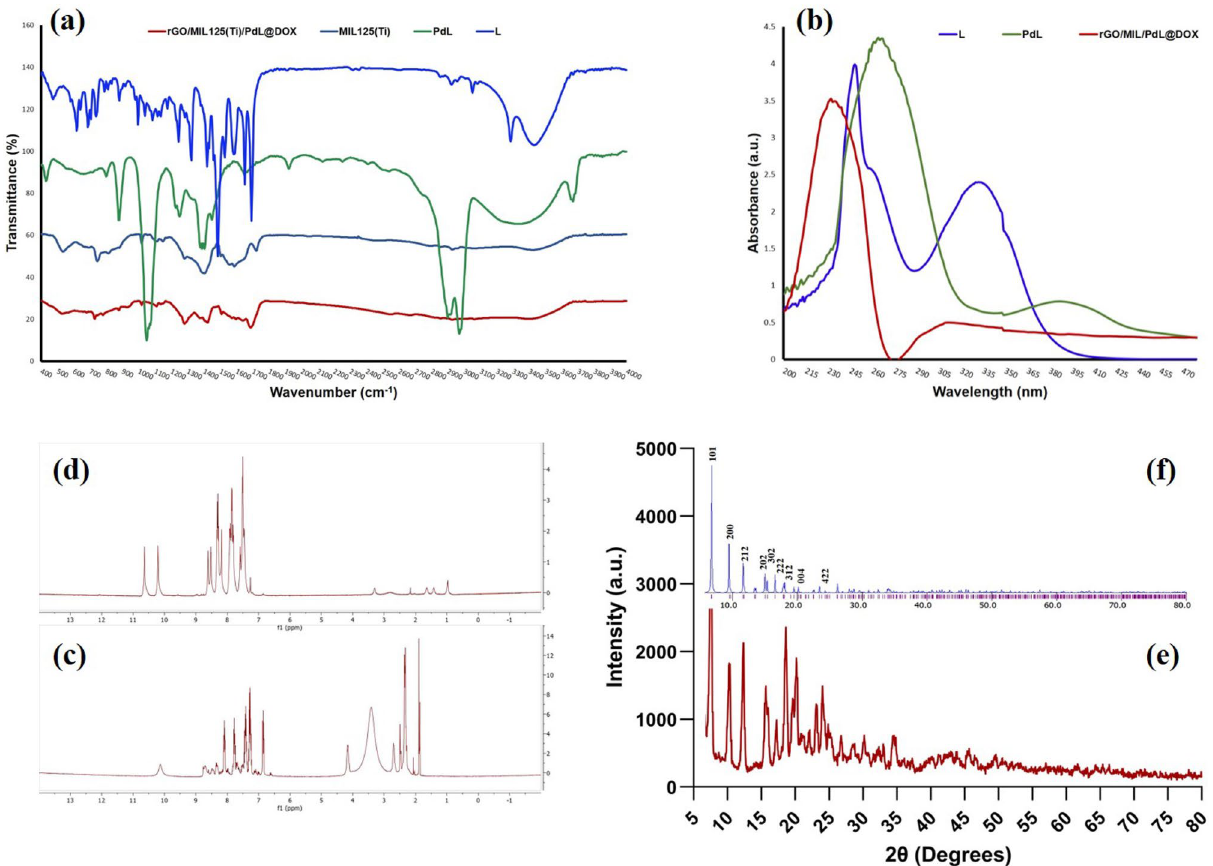
Figure 2. ( a ) The FT-IR spectra of; L: (3,4-Bis(2-pyridinecarboxamido)benzophenone), PdL: (Pd(3,4-Bis(2- pyridinecarboxamido)benzophenone)), MIL125(Ti), and nanocomposite: rGO/MIL-125(Ti)@PdL@DOX. ( b ) The UV–Vis spectra of; L, PdL, and nanocomposite. The 1 H NMR spectra of: ( c ) PdL, ( d ) L. The PXRD spectra of e : prepared MIL-125(Ti) ( f ) simulated